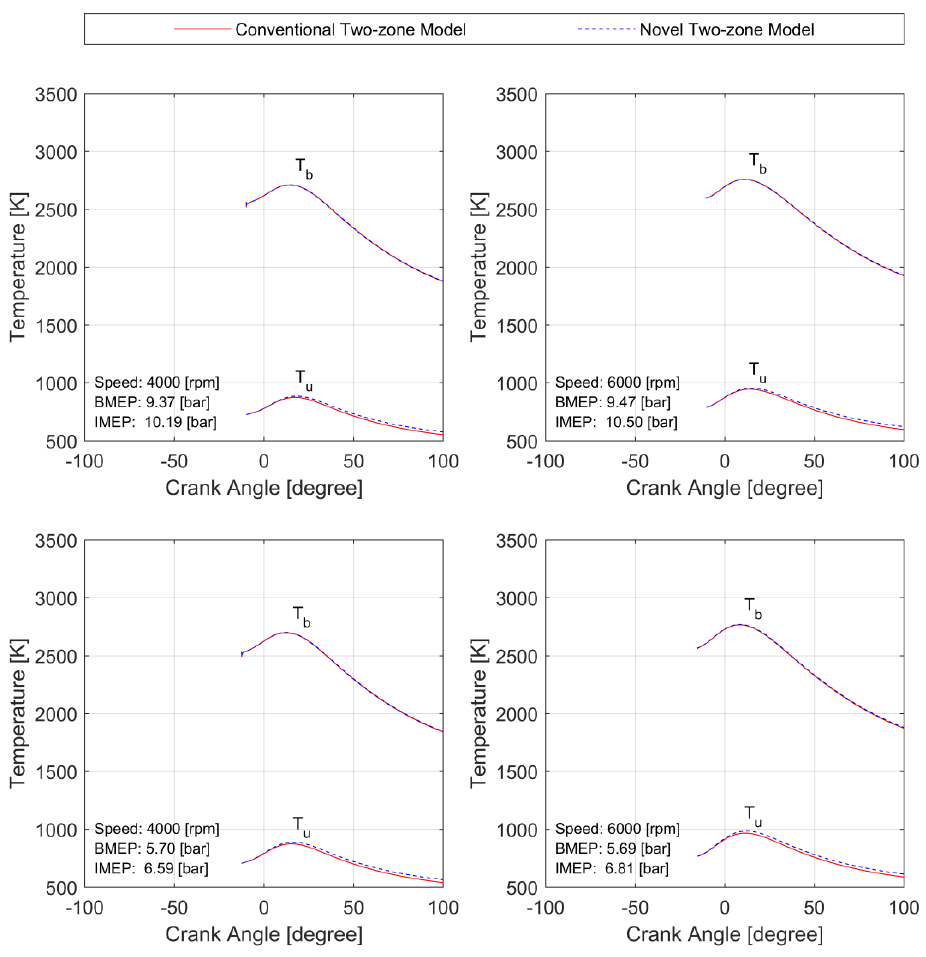
Figure 8. Simulated temperature from conventional and novel two-zone model.